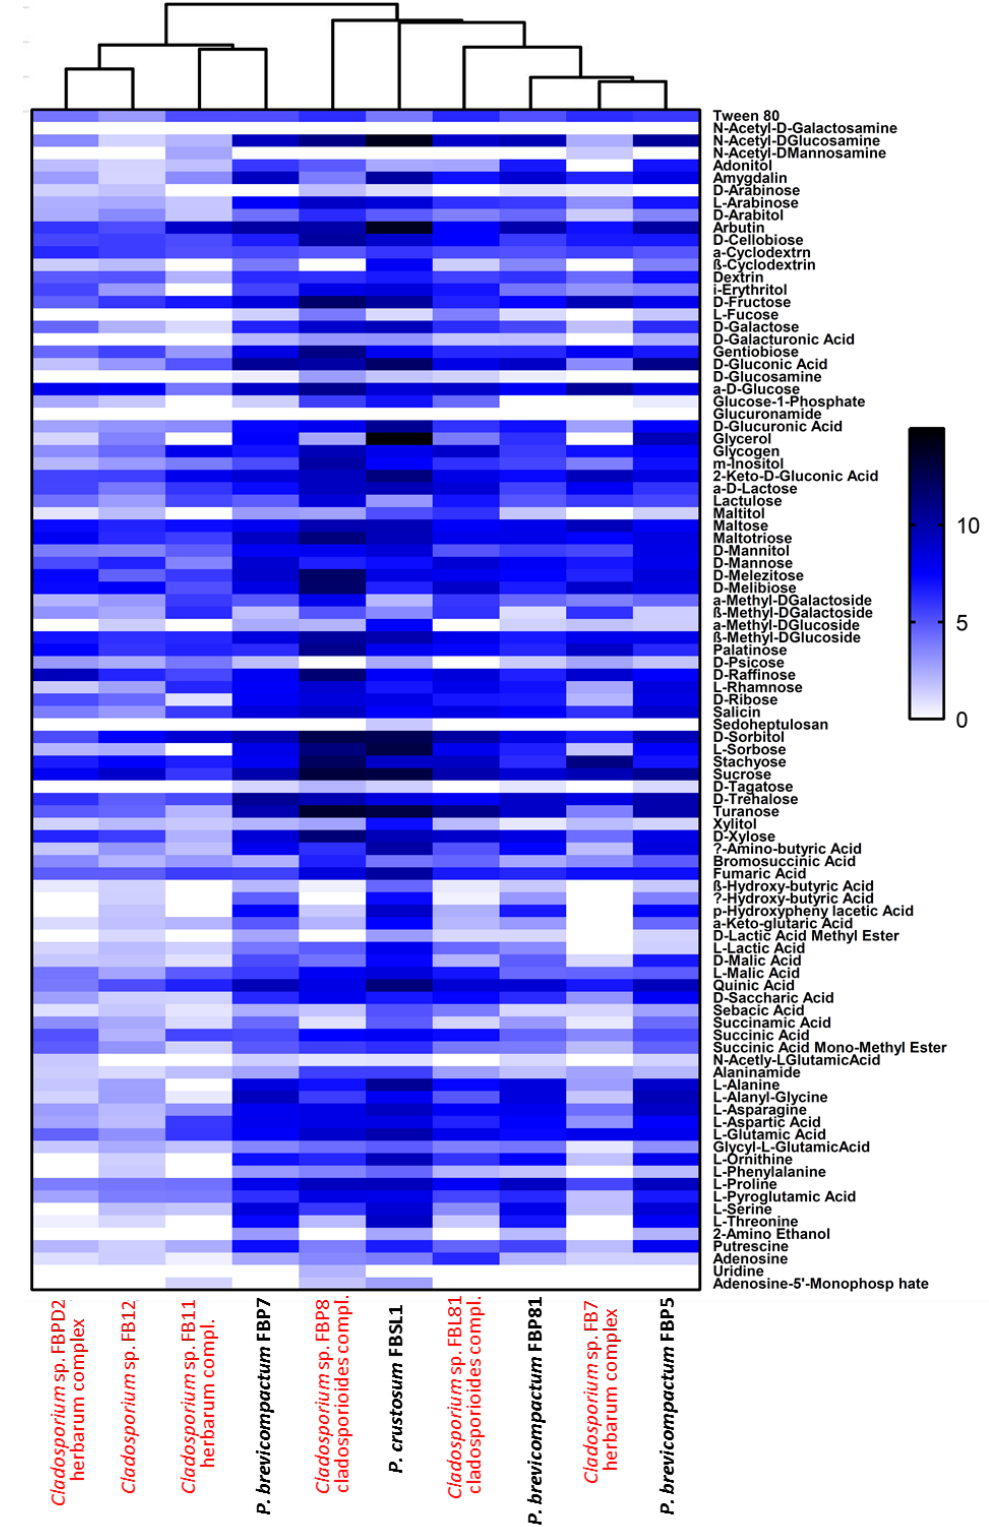
Figure 8. Comparative heatmap of Cladosporium and Penicillium strains grown on Biolog FF MicroPlates™ after 108 consecutive hours based on the utilization of 95 different carbon sources with two replicates each. The white to black color gradient indicates poor to high growth on the respective substrates (color scale = specific AUC value).